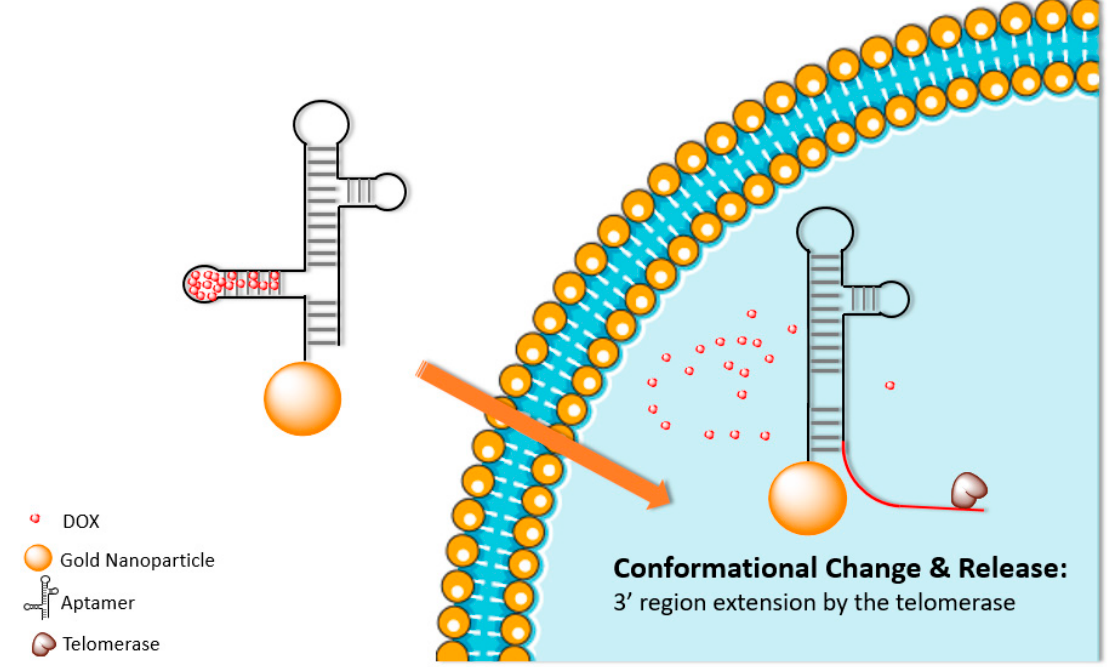
Figure 2. Graphic representation of telomerase extending the 3’end aptamer which leads to the conformation change of the aptamer and release of the DOX inside tumour cells.